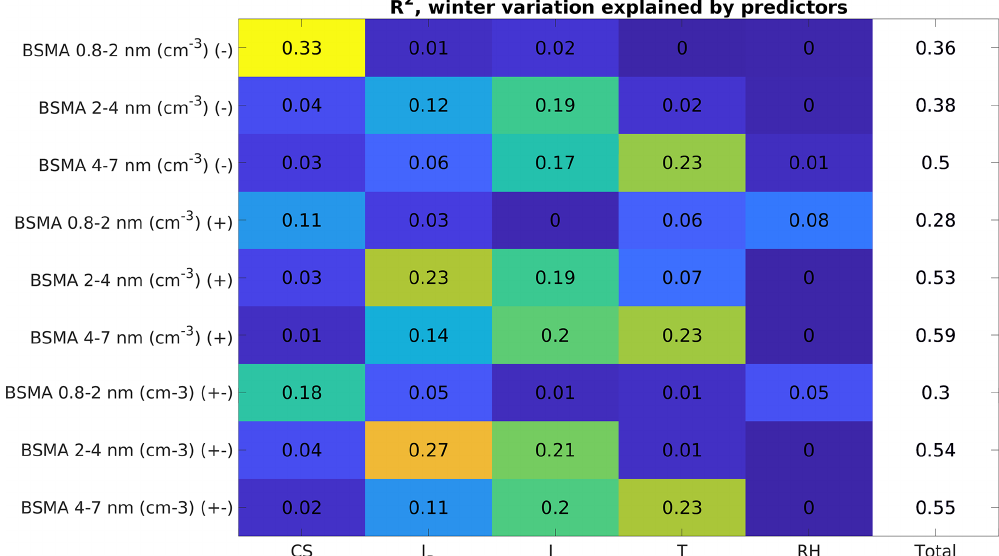
https://doi.org/10.5194/acp-22-15223-2022 Atmos. Chem. Phys., 22, 15223–15242,